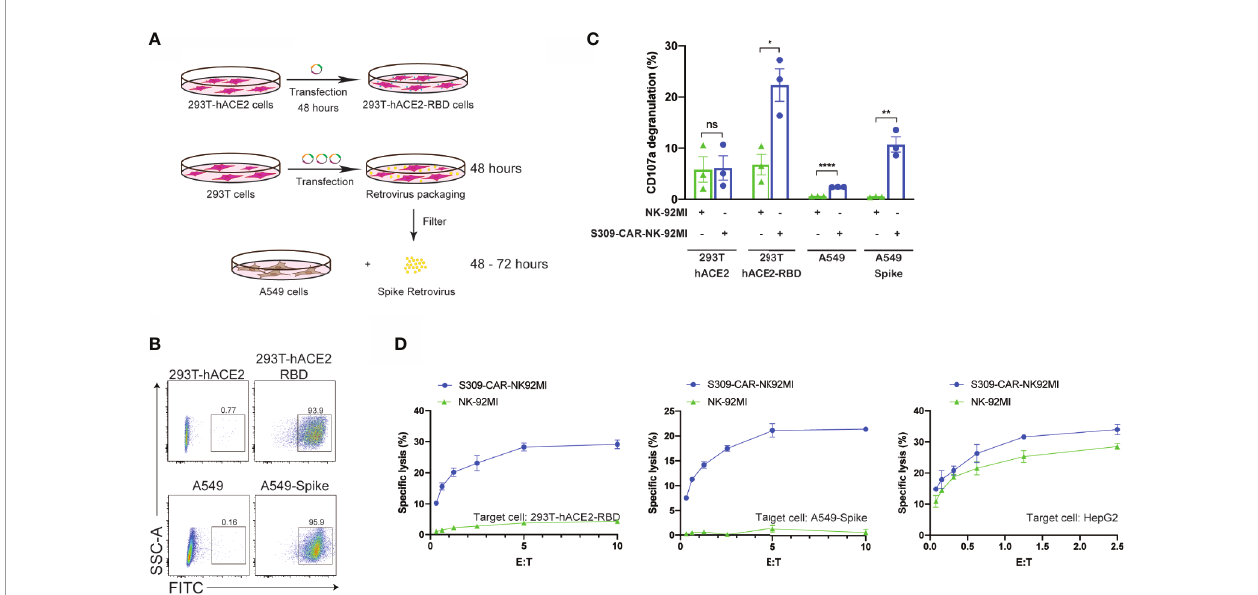
FIGURE 3 | Increased CD107a surface expression and killing activity of S309-CAR-NK-92MI cells against 293T-hACE2-RBD and A549-Spike target cells. (A) Generation of transient 293T-hACE2-RBD and stable A549-Spike cell lines. 293T-hACE2 cells were transfected with RBD-containing plasmid for 48 hours. Transfected 293T-hACE2-RBD cells were then harvested. For the generation of A549-Spike, 293T cells were transfected with the retrovirus transfection system for 48 hours. The spike retrovirus was fi ltered and transduced into A549 cells for an additional 48-72 hours. (B) Representative dot plots showing the expressions of RBD or Spike in 293T-hACE2 or A549 cells, respectively. 293T-hACE2-RBD and A549-Spike cells were stained with anti-RBD and the expressions were con fi rmed by fl ow cytometry. The stable A549-Spike cell line was then sorted to achieve high levels of spike expression. (C) Quantitative data of CD107a surface expression assay of S309-CAR-NK against 293T-hACE2-RBD or A549-Spike cell lines. Brie fl y, S309-CAR-NK-92MI cells were cocultured with either 293T-hACE2-RBD cells, A549-Spike cells, stimulated with PMA/Ionomycin, or incubated alone for 2 hours at 37°C. Cells were then harvested and stained for CAR F(ab ’ )2 domain IgG (H+L) and CD107a. Each dot represents an experiment. Data represent means ± SEM from three independent experiments. (D) Representative 4-hour standard Cr 51 release assay of S309-CAR-NK-92MI and parental NK-92MI cells against various target cell lines. 293T-hACE2-RBD, A549-Spike, and HepG2 cell lines were used as target cells for S309-CAR-NK-92MI and NK-92MI. Experimental groups were performed in triplicates. Error bars represent means ± SD. The experiment was repeated at least two times. Non-parametric test was used for panels (C) . ns p > 0.05, *p < 0.05, **p < 0.01, ****p <